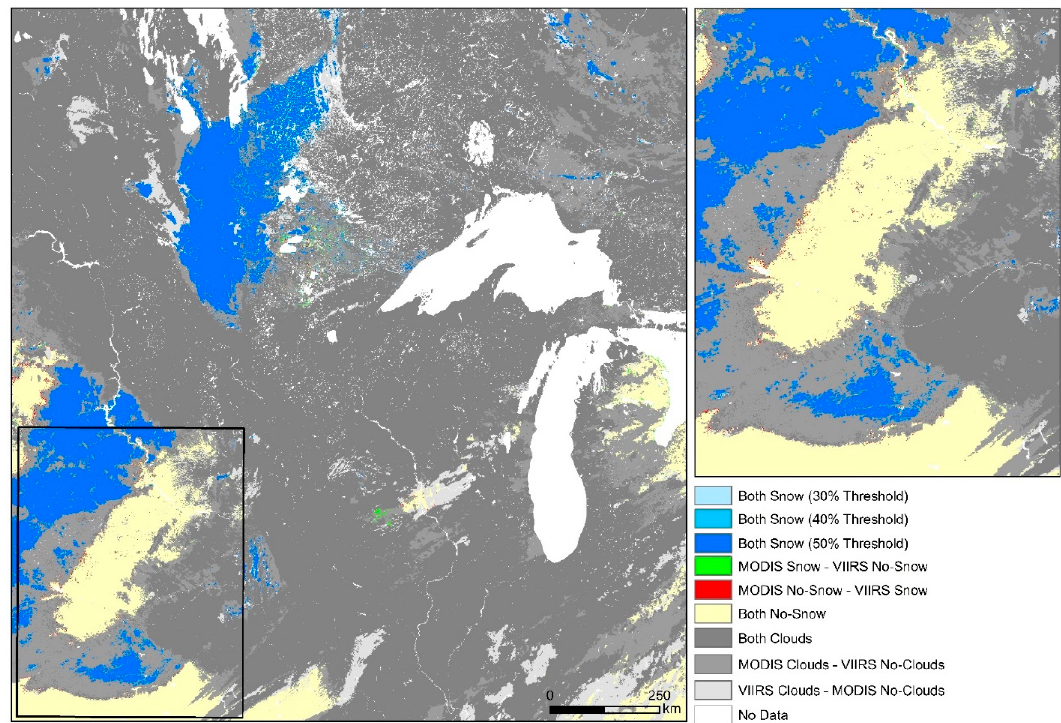
Figure 11. MODIS and VIIRS snow comparison map for 24 December 2015 illustrating disagreement over snow/no-snow transition zone where MODIS mapped cloud but VIIRS did not.